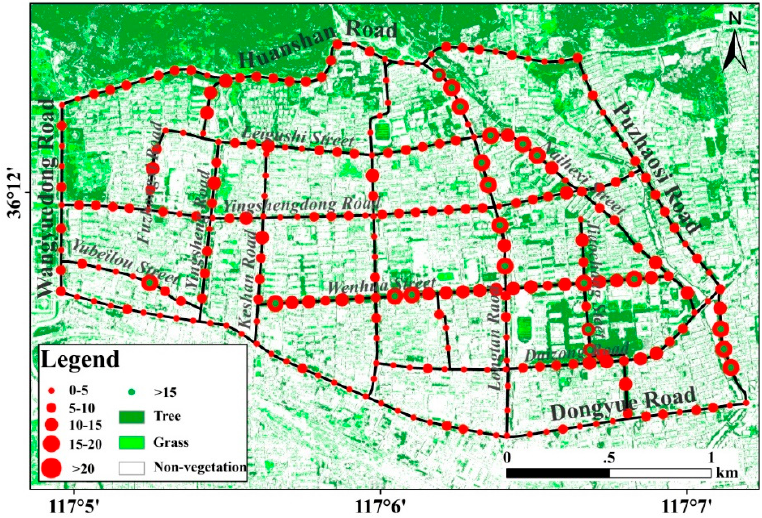
Figure 8. BGVI results of the sample sites in the study area overlaid on the land cover